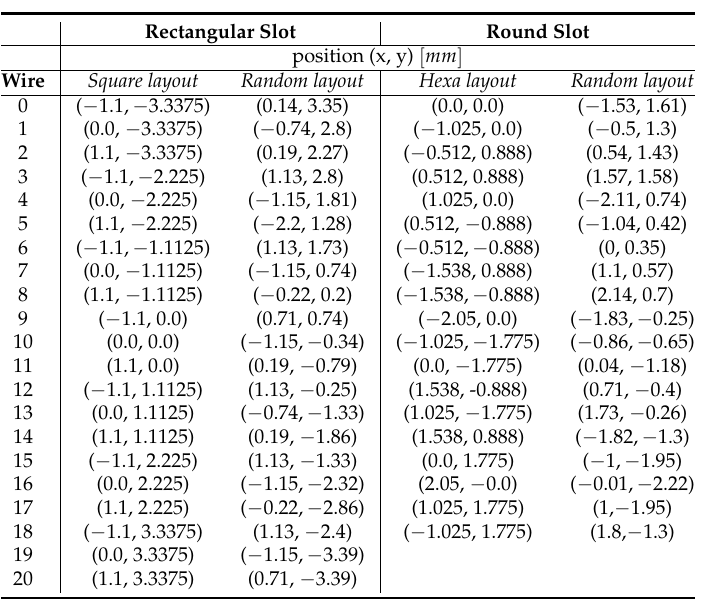
Table A2. Wire positions in 4 slot applications cf. Figures 2 and 10, the origin point is at the slot gravity